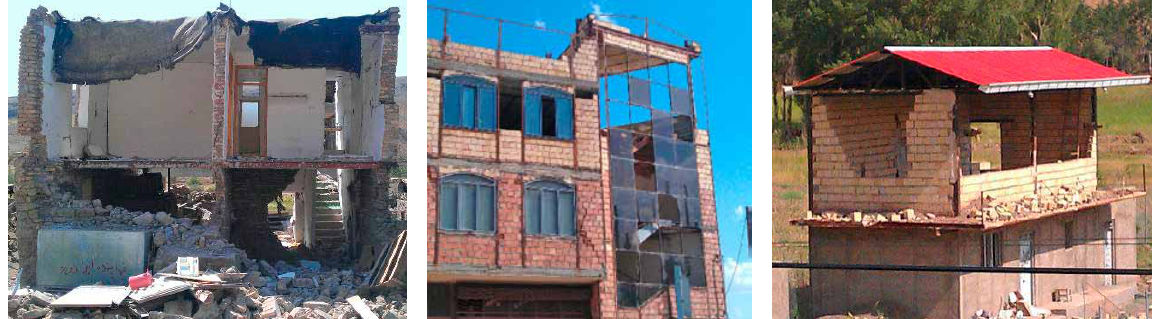
fig. 2. an example of earthquake area destruction due to seismic